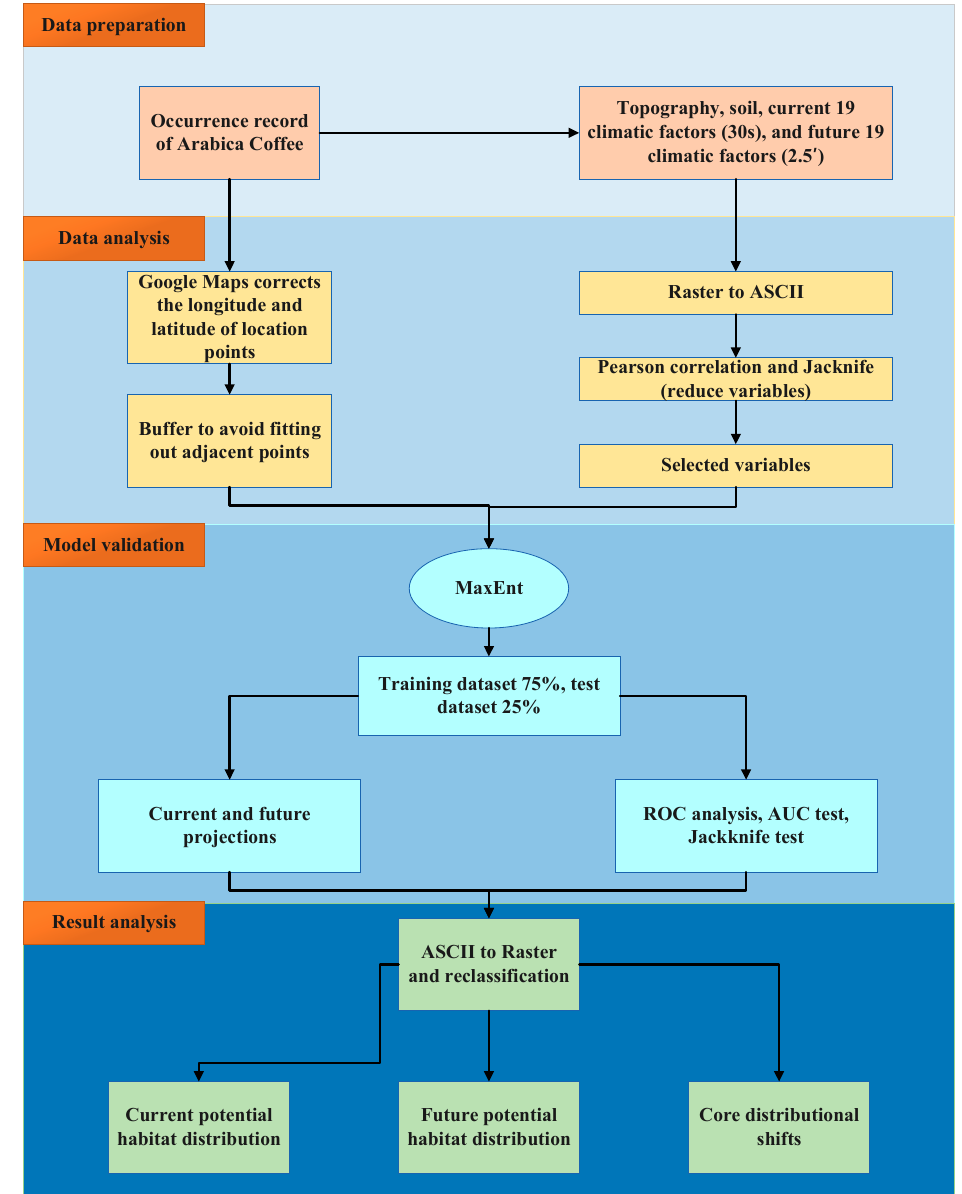
Figure 3. Processing methodology inflow diagram (AUC (area under the curve) and ROC (receiver operator curve)).